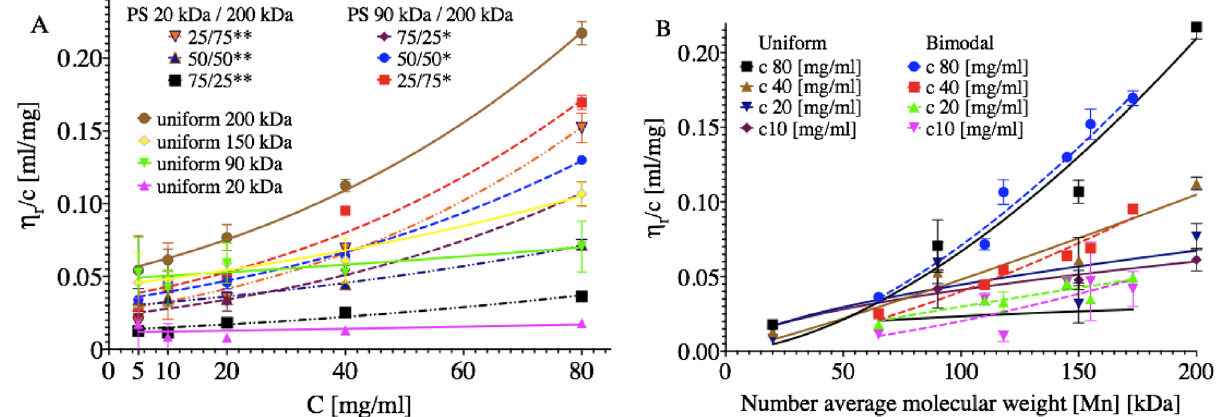
Figure 2. Reduced viscosity η r /C of the solutions, ( A ) η r /C plotted against the solution’s concentration. Curves represent fits for Eq. 1; ( B ) η r /C plotted as a function of the number average molecular weight function. Curves represent the Mark-Houwink equation fit (Eq. 2), [M n ] = f 1 M w1 + f 2 M w2 , where f is w/w % ratio of